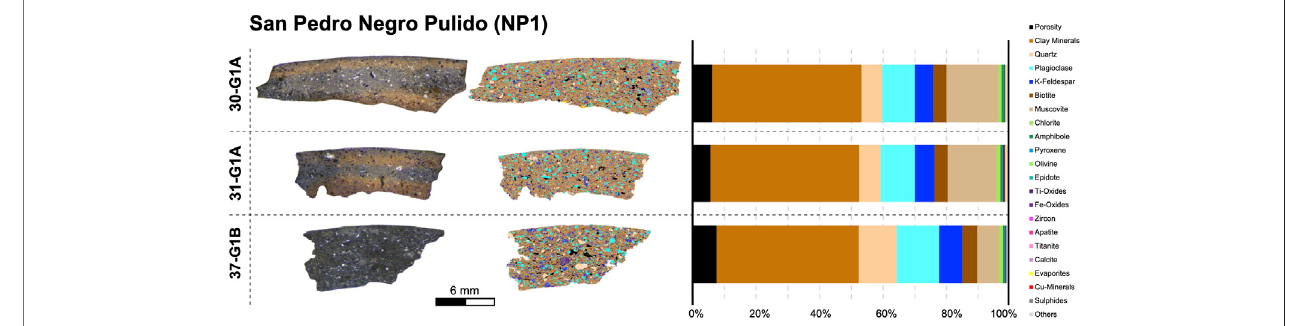
FIGURE 8 | Fresh pastes (left), mineralogical maps (middle), and modal mineralogy (right) of the studied San Pedro Negro Pulido (NP1) ceramic samples.